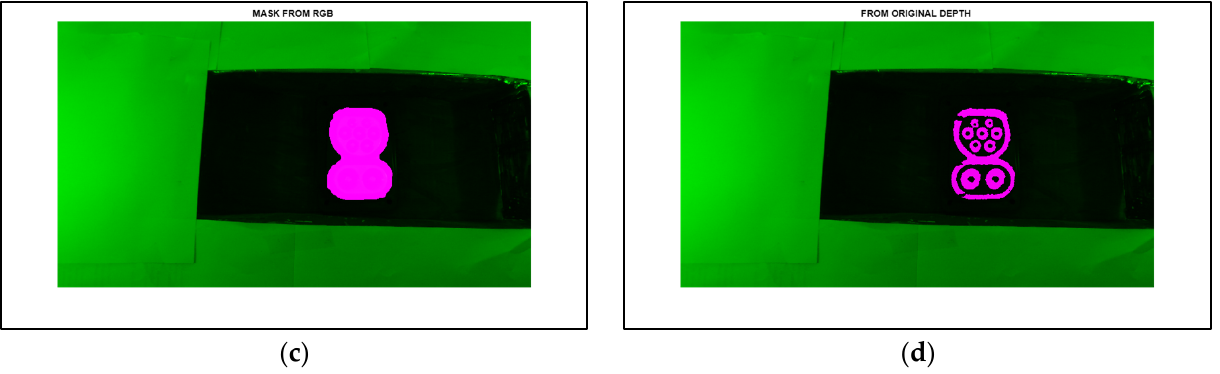
Figure 12. ( a ) Input RGB image, ( b ) result of the intensity transformation, ( c ) obtained binary mask, and ( d ) detected CCS2 connector.